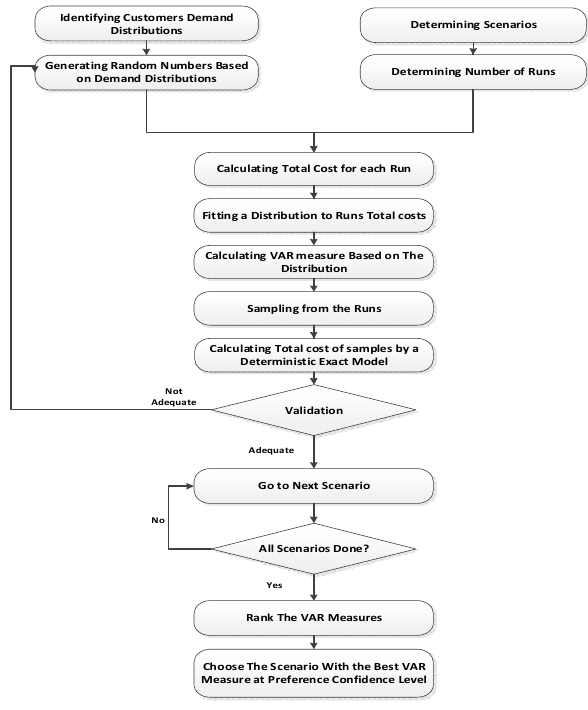
Fig. 2. The proposed simulation optimization